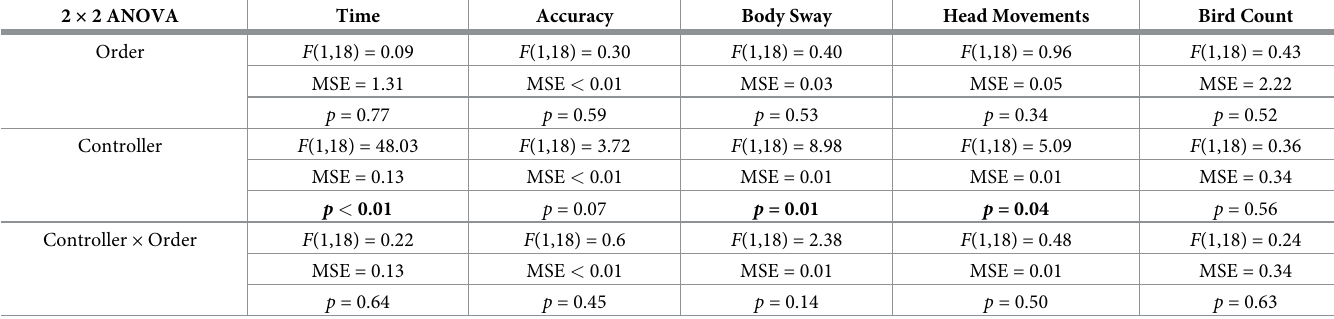
Table 4. Analysis of performance and additional measures from Experiment 2. Significant results ( p < 0.05) are bold. 2 × 2 ANOVA Time